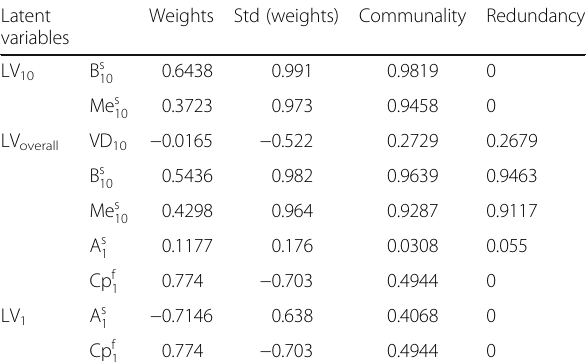
Table 2 Variables tested for multivariate regression model Table 3 Summary statistics for outer model of derived partial-least-square path modeling